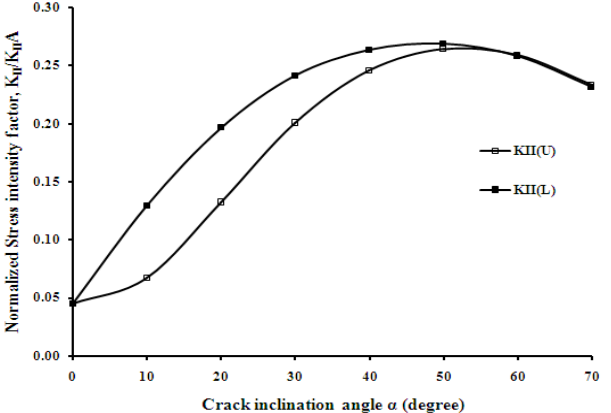
Figure 12: Effect of crack inclination angle α on K I for two parallel cracks; a/W = 0.08, k = 0.75, S = 1.5 and B = 24